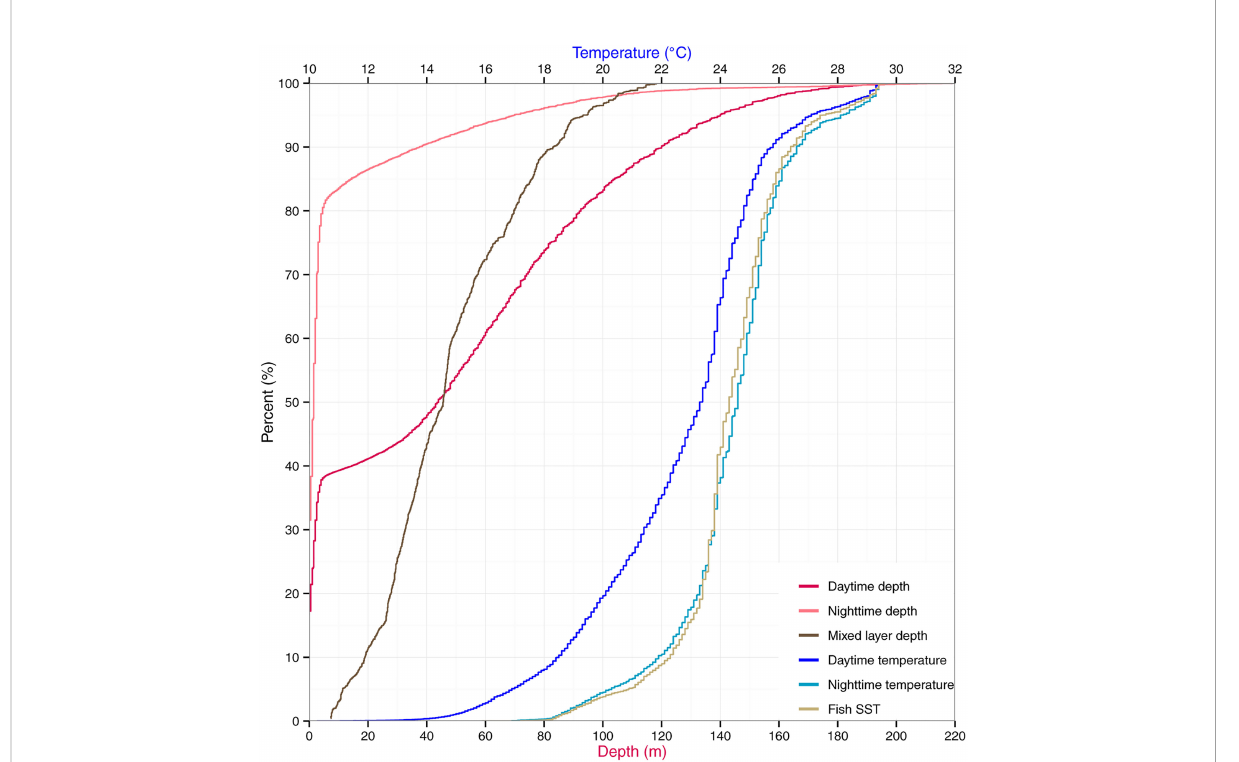
FIGURE 1 Vertical habitat of striped marlin. Depth and temperature are expressed as cumulative percentages for daytime and nighttime. Daily sea surface temperature (Fish SST) and mixed layer depth are also